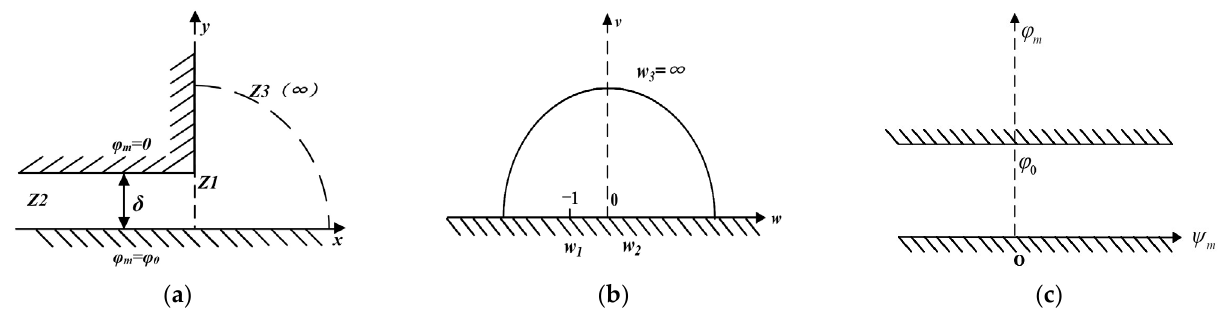
Figure 7. SCT analysis diagram of UP-LPST end effect. ( a ) z plane; ( b ) w plane; ( c ) t plane.